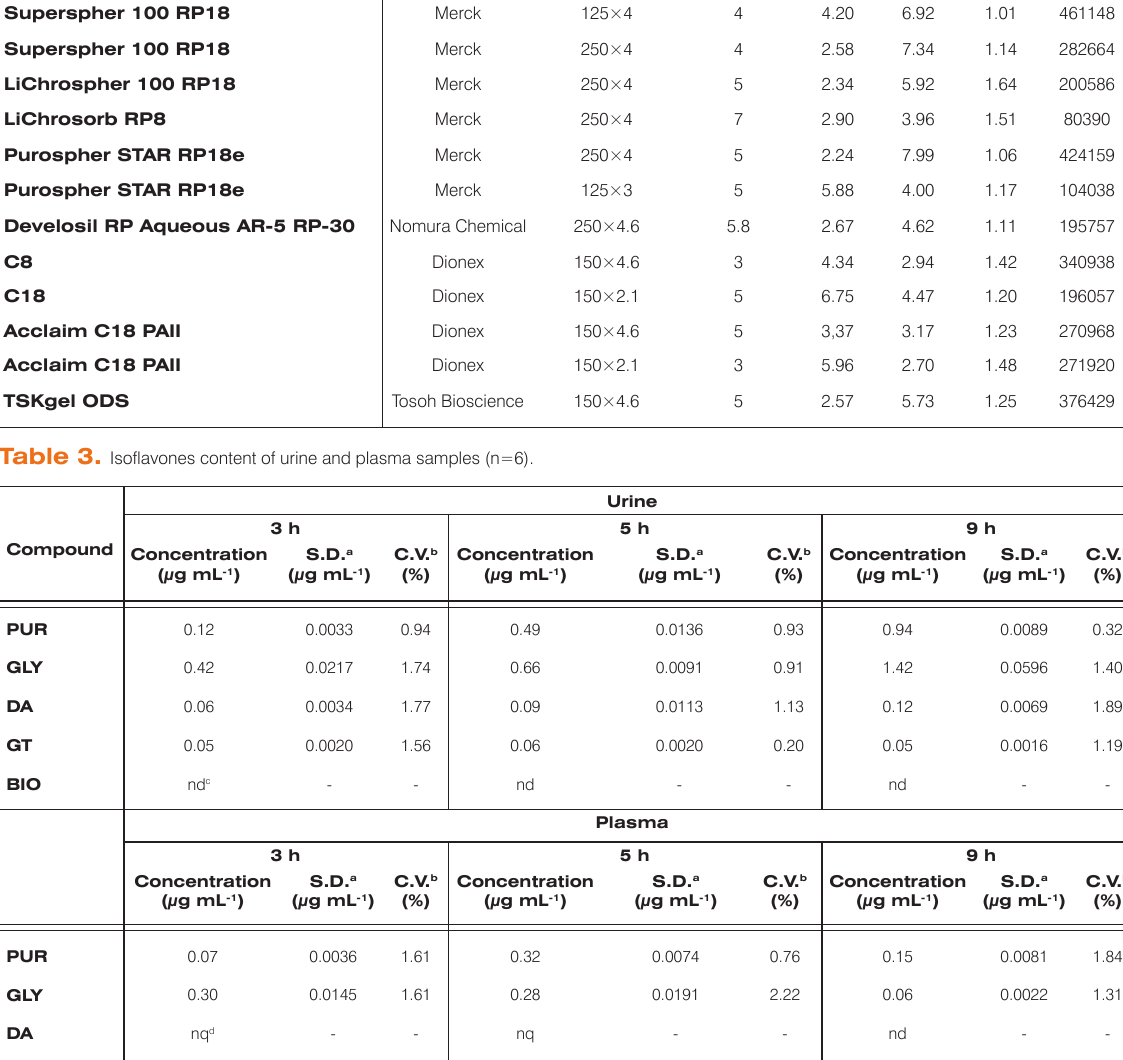
Table 2. Performance characteristics of the columns.